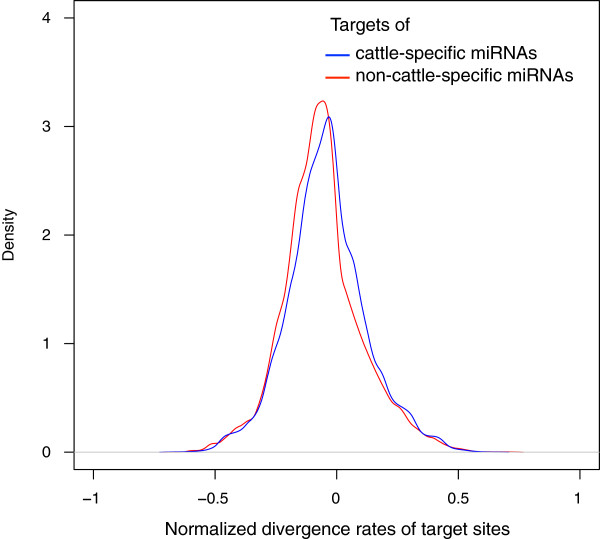
The distribution of normalized divergence rates of miRNA target sites. Density plots of the normalized target site divergence rates between cattle and human for cattle-specific (blue line) and non-cattle-specific miRNAs (red line). The targets of the cattle-specific miRNAs show a greater normalized divergence rate than the targets of the non-cattle-specific miRNAs (p = 2.2e-16, Kolmogorov-Smirnov test).